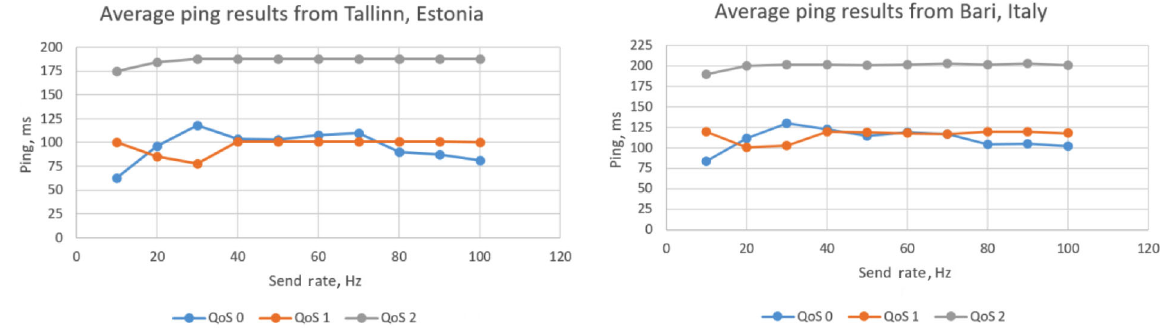
Fig. 4. Experiment